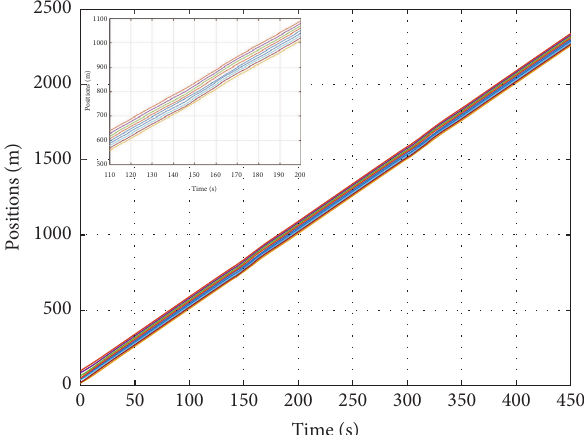
Figure 3: The optimal spacing platoon trajectories of